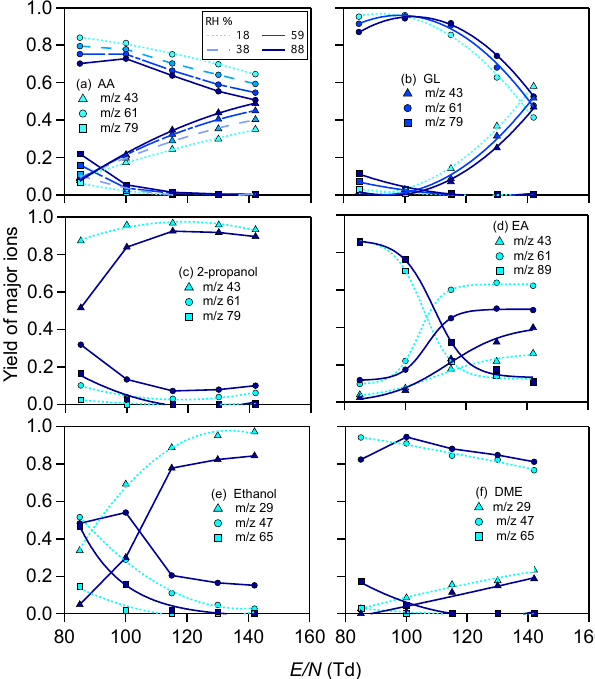
Figure 6. Yields of major product ions originating from (a) AA, (b) glycolaldehyde, (c) 2-propanol, (d) ethyl acetate, (e) ethanol, and (f) DME as a function of E/N and humidity. Those of FA are not shown here because no fragmentation product was detected by